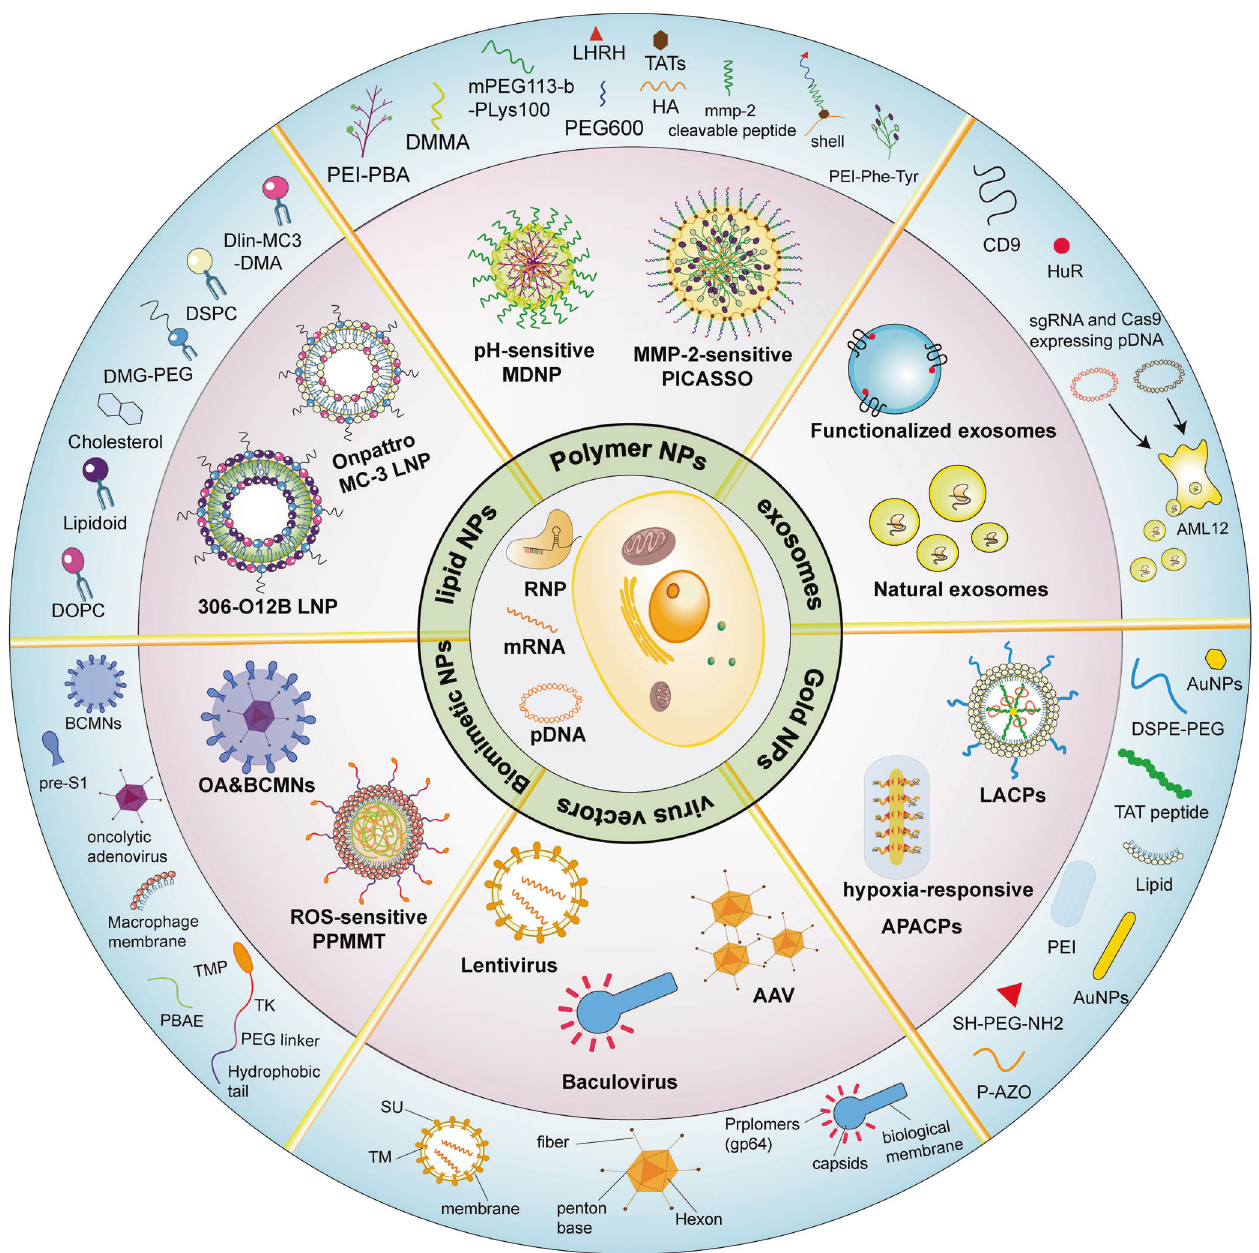
Fig. 5 Schematic diagram showing multiple types of vectors for the in vivo delivery of CRISPR systems. The central region shows three forms of CRISPR action: pDNA, mRNA, and RNP. The middle circle section shows examples of delivery carriers, and the outermost area shows how the carriers are produced or the components. SU surface envelope protein, TM transmembrane envelope protein. (Figure was created with Adobe Illustrator and